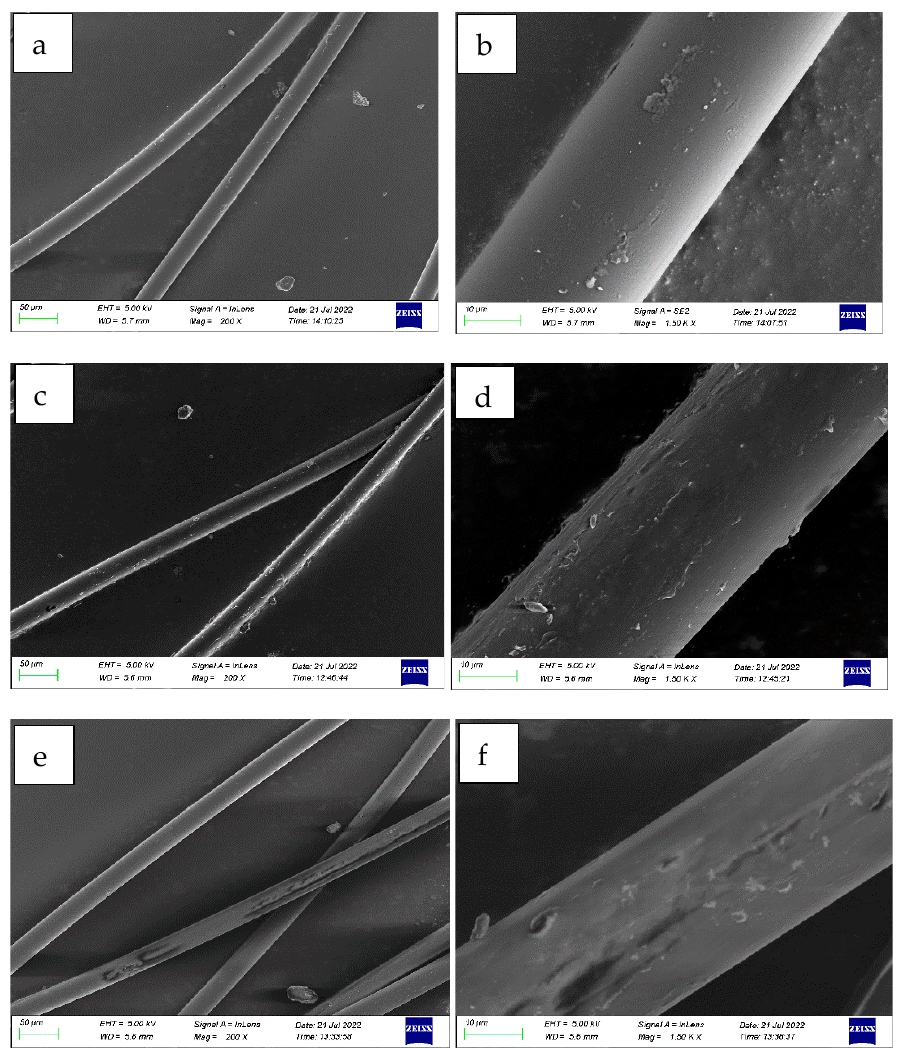
Figure 4. SEM images of fabric samples. ( a , b ) original fabric; ( c , d ) NaOH-treated fabric, ( e , f ) KH550- grafted fabric.